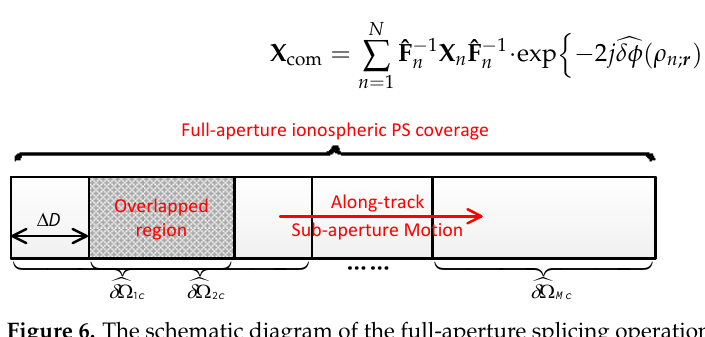
Figure 6. The schematic diagram of the full-aperture splicing operation.